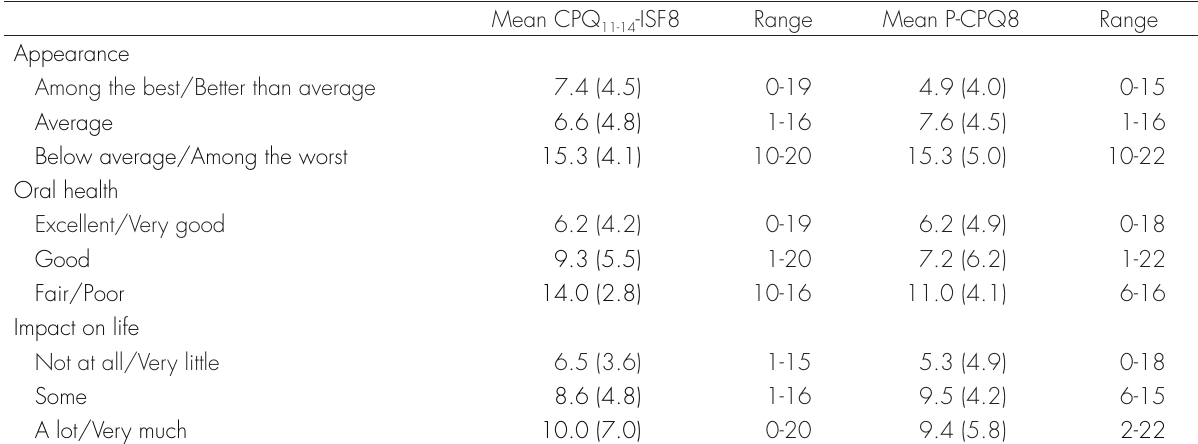
Table II. Mean CPQ11-14-ISF8 and P-CPQ8 scale scores by responses to global questions at T0 (brackets contain standard deviations, unless otherwise